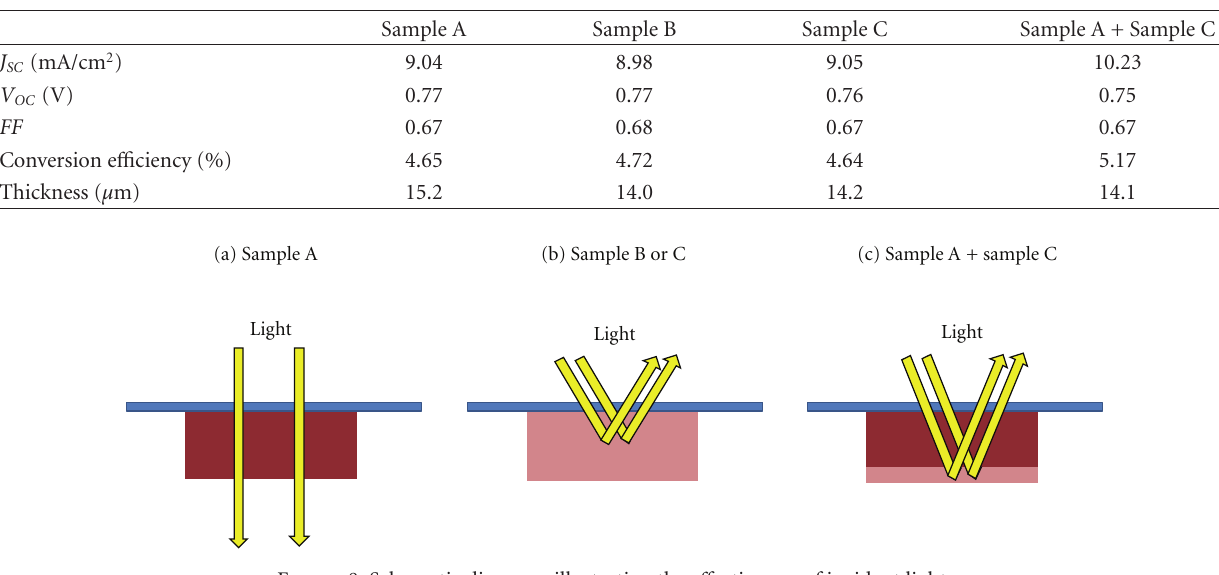
Figure 8: Schematic diagrams illustrating the e ff ective use of incident light.